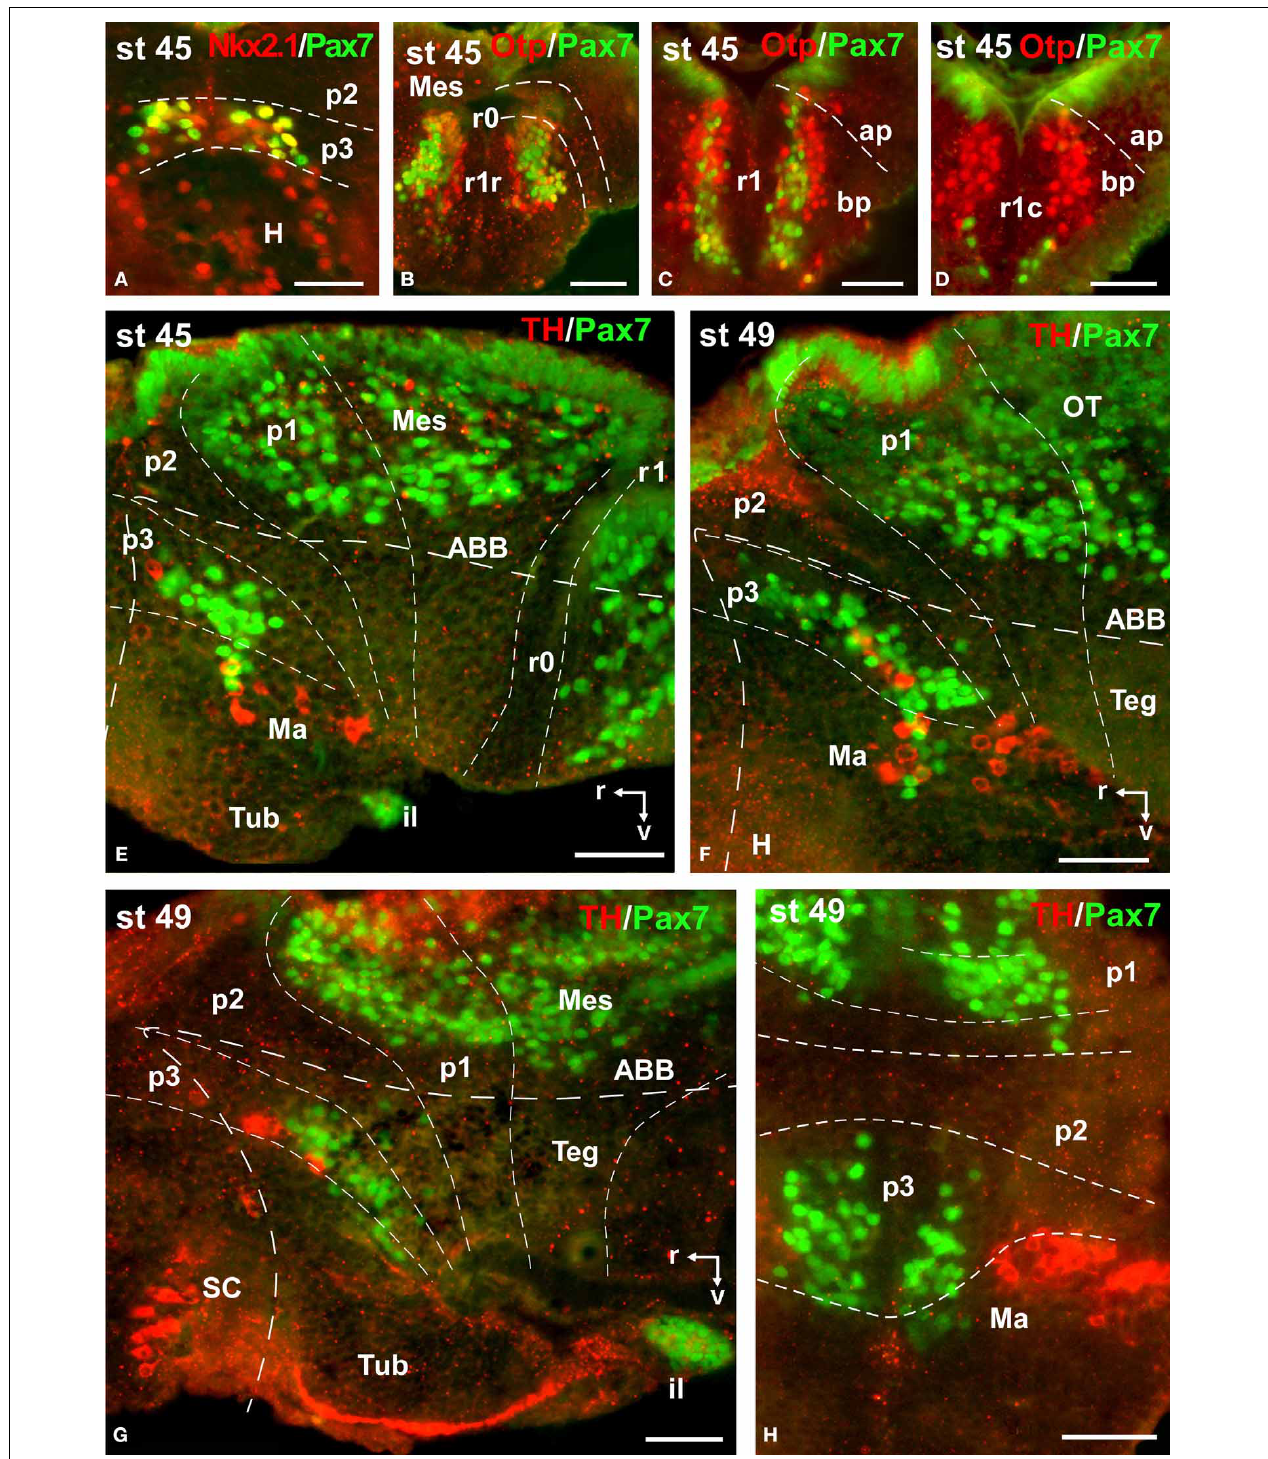
FIGURE 9 | Photomicrographs of double-labeled transverse (A–D,H) and sagittal (E–G) sections through the brain of Xenopus laevis showing the localization of Pax7 cells (green fluorescence) in relation to the markers Nkx2.1, Otp, and TH (red fluorescence; indicated in color code in the upper right corner of each photomicrograph). The developmental stages